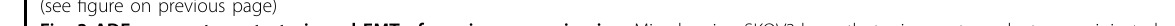
Fig. 3 ADEs promote metastasis and EMT of ovarian cancer in vivo. Mice bearing SKOV3-luc orthotopic xenotransplants were injected intraperitoneally with #7 ADEs or PBS. a Bioluminescence images of abdominal metastasis in mice bearing SKOV3-luc orthotopic xenotransplants. b Growth curve of SKOV3-luc tumors based on the quantitative radiance values from IVIS imaging. ( c ) Bioluminescence images of metastases on abdominal organs. The organs arranged clockwise from the top are the liver, spleen, kidneys, pancreas, and omentum. d Quantitative radiance values from IVIS imaging in metastases on abdominal organs. e , f The size and weight of the ovarian primary tumors from each group of nude mice. g Immunohistochemical analysis of the expression of E-cadherin, N-cadherin, and Vimentin in tumor tissues. Scale bar, 20 μ m. h Diagram of the calculated percentage of Ki67 staining and mean density of E-cadherin, N-cadherin, and Vimentin in the two groups (* p < 0.05; ** p < 0.01; *** p <